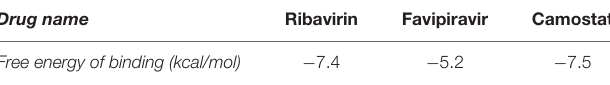
TABLE 3 | The binding affinity of the unconfirmed drugs predicted by DRMNN to the target PDB ID: 2VIU.